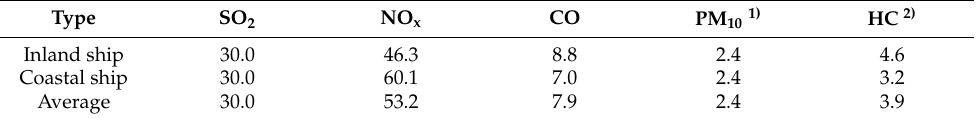
Table A3. Emission factors of fishing